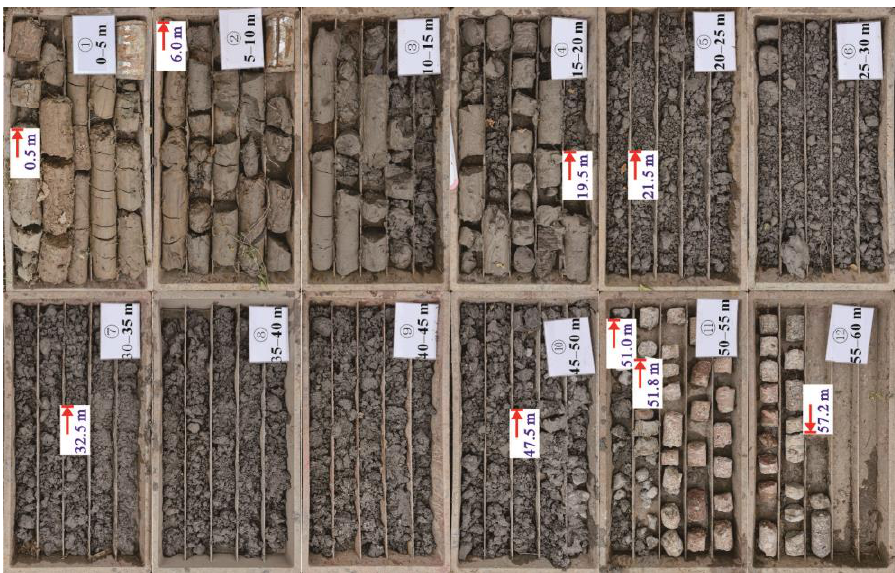
Figure 5. Core sample photos of borehole zk43.